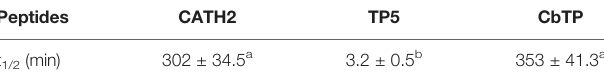
TABLE 2 | Half-life of CbTP in human serum.